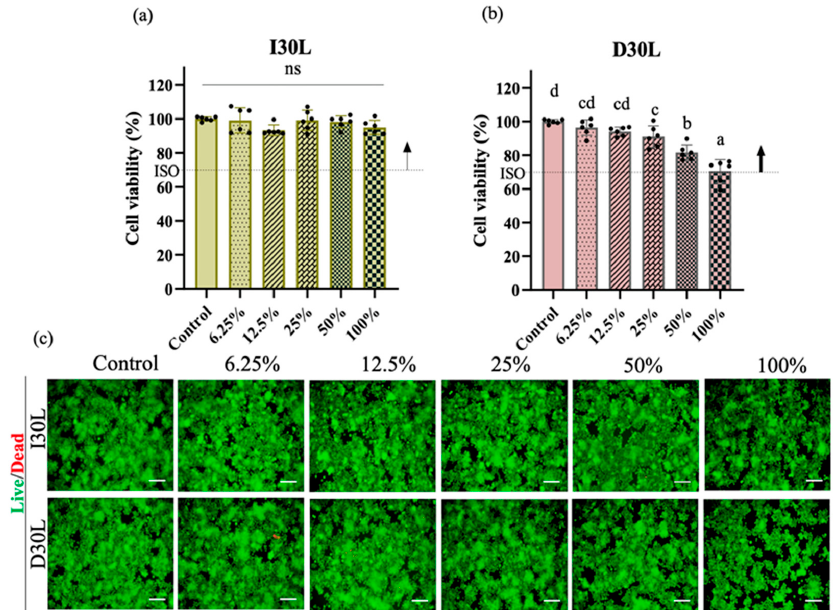
Figure 4. Osteoclast precursors viability test of NaI-based paste using extract compared to iodoform- based paste. ( a , b ) Cytotoxicity of the extract of NaI-based paste and iodoform-based paste using osteoclast precursors and extracted solutions of di ff erent concentrations (control, 12.5, 25, 50, 100%) for 24 h. Arrows indicate ISO standards with the dashed line (70%) represents the cuto ff level estab-